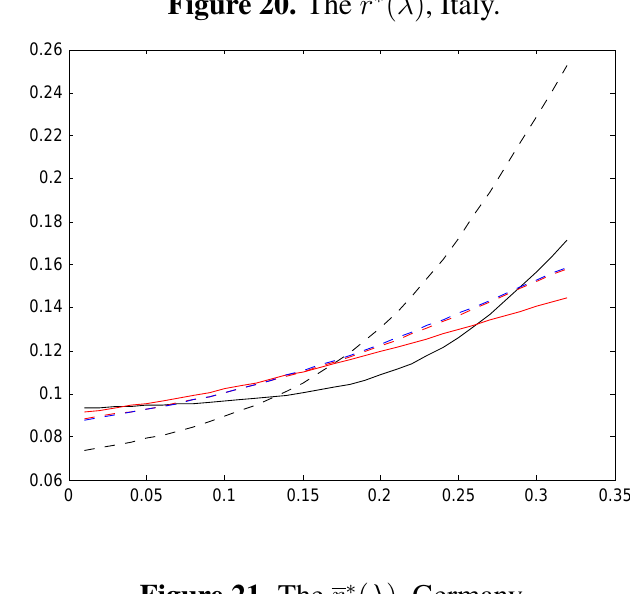
Figure 21. The r ∗ ( λ ) ,